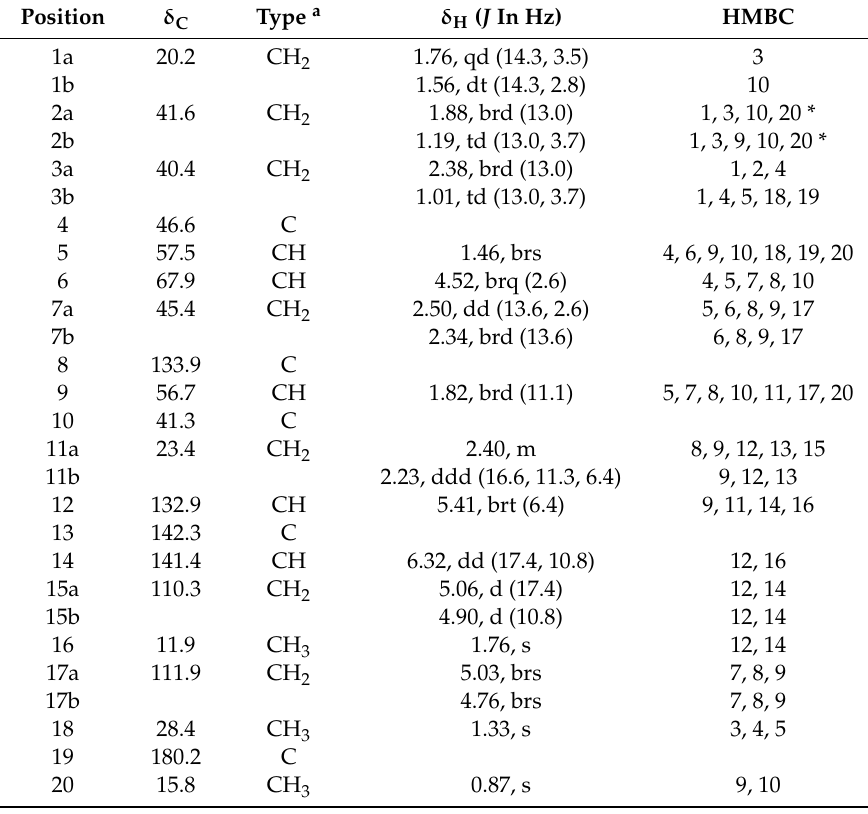
Table 2. NMR Data ( 1 H 700 MHz and 13 C 175 MHz, CDCl 3 ) of 2 .